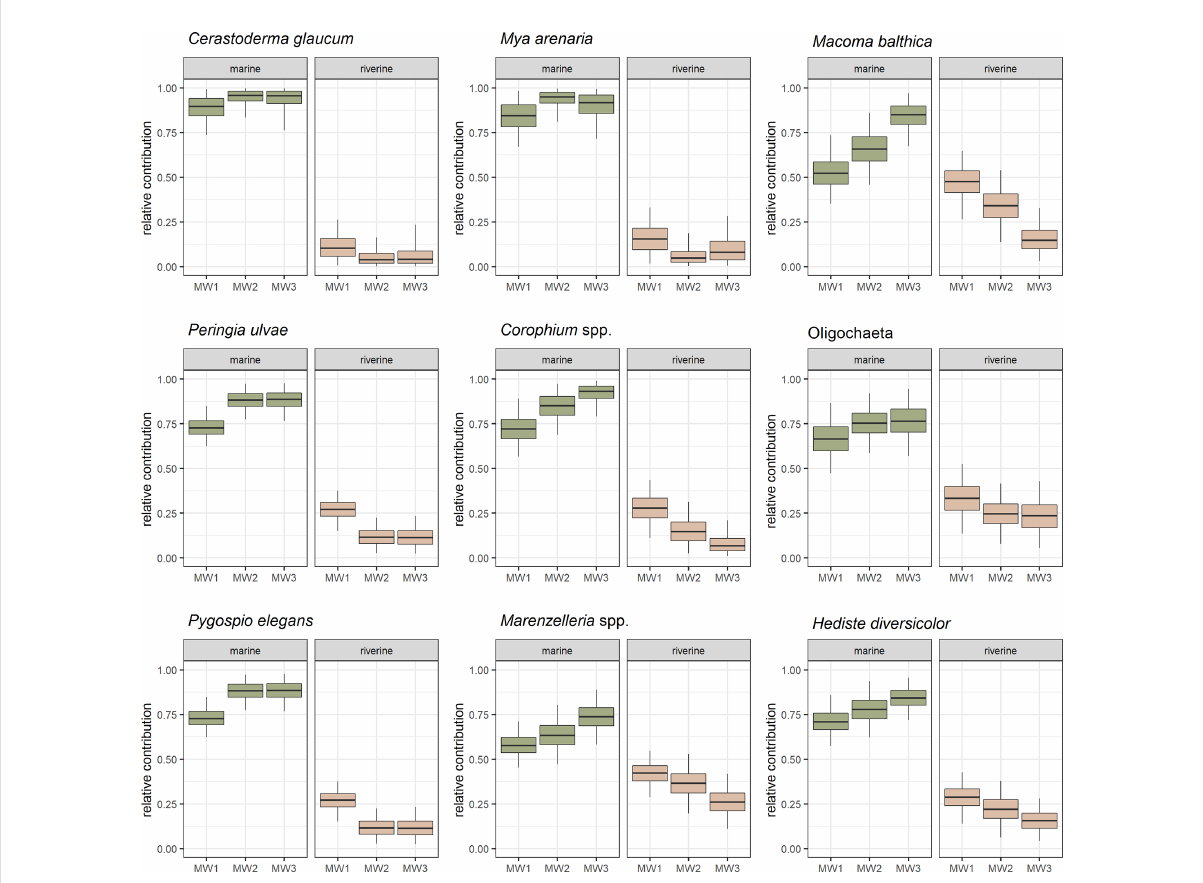
FIGURE 5 The probability distribution of relative contribution [%] of marine and riverine food sources in the diet of the common benthic taxa at sampling stations (MW1, MW2, MW3). Boxplots depict median (horizontal line) with 50% (box) and 95% credible intervals (vertical